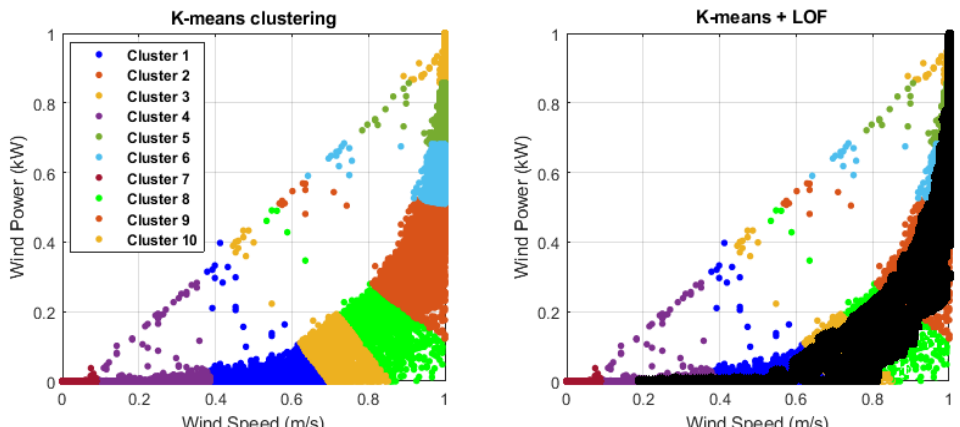
Figure 6. The K-means clustering method performance and the applied data (WT1) divided into 10 clusters ( left ). The dark points represent the clean SCADA data after applying the LOF ( right ).